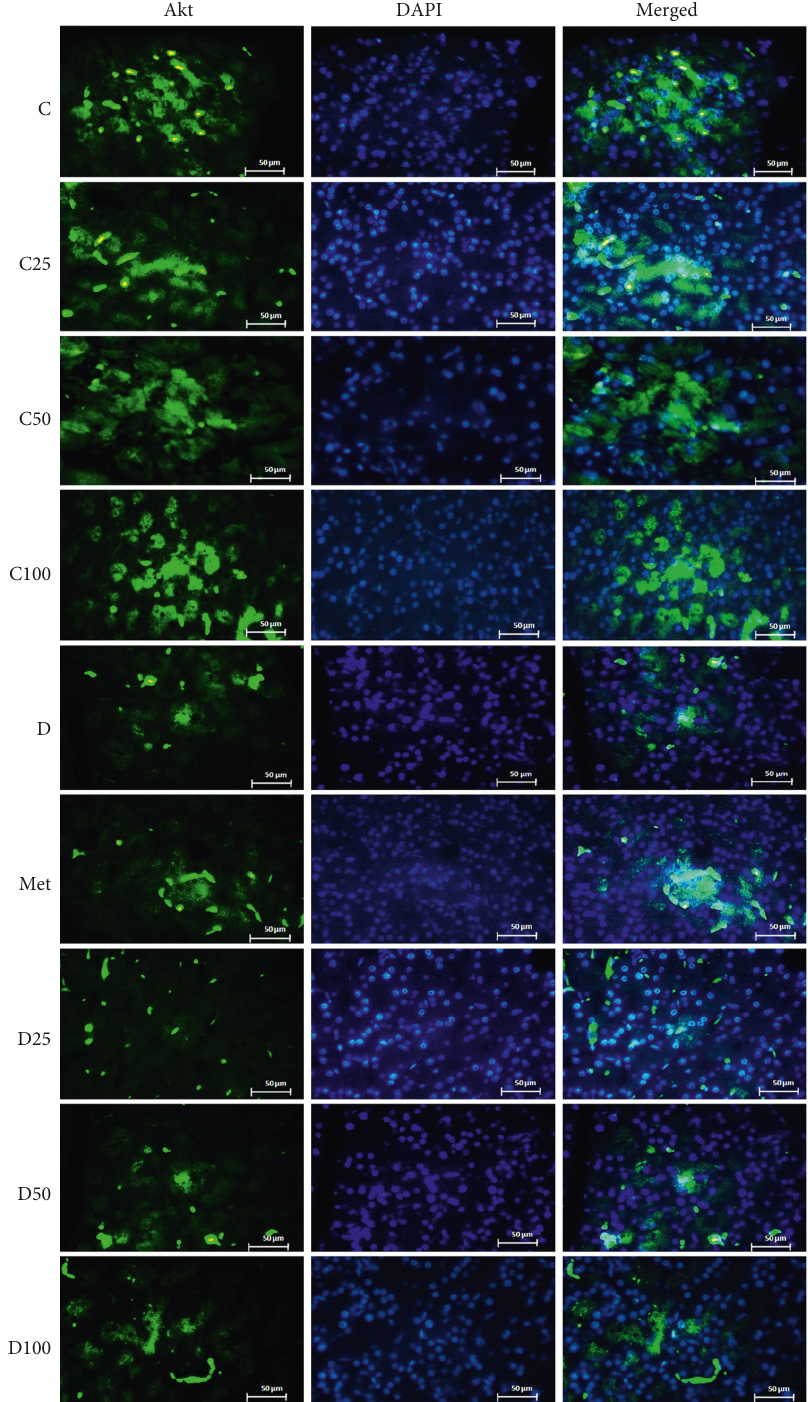
Figure 2: Fluorescence immunocytochemistry analysis of Akt. C: control rats, D: the sham or diabetic rats, MET: diabetic rats +metformin (55mg/kg), C25: control rats +p-cymene (25mg/kg), C50: control rats +p-cymene (50 mg/kg), C100: control rats +p-cymene (100mg/kg), D25: diabetic rats +p-cymene (25mg/kg), D50: diabetic rats +p-cymene (50mg/kg), and D100: diabetic rats+p-cymene (100mg/kg). Magnification 400x. Scale bar 50 μ